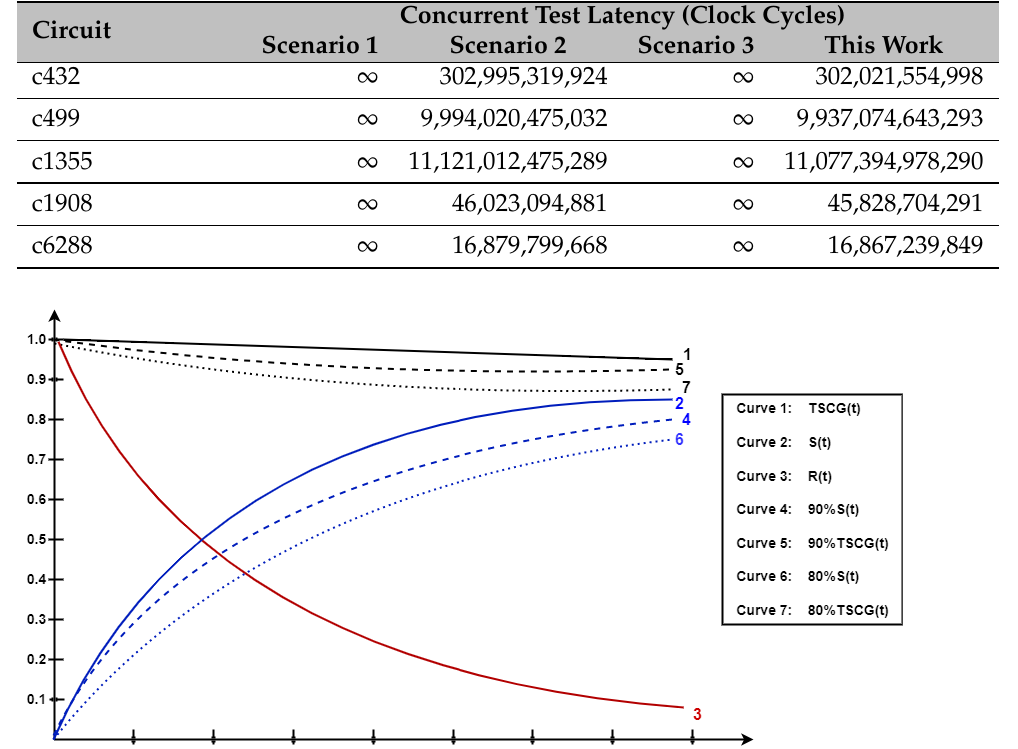
Table 5. CTL under three scenarios using the MICSET and after the application of the proposed adaptive BIST.